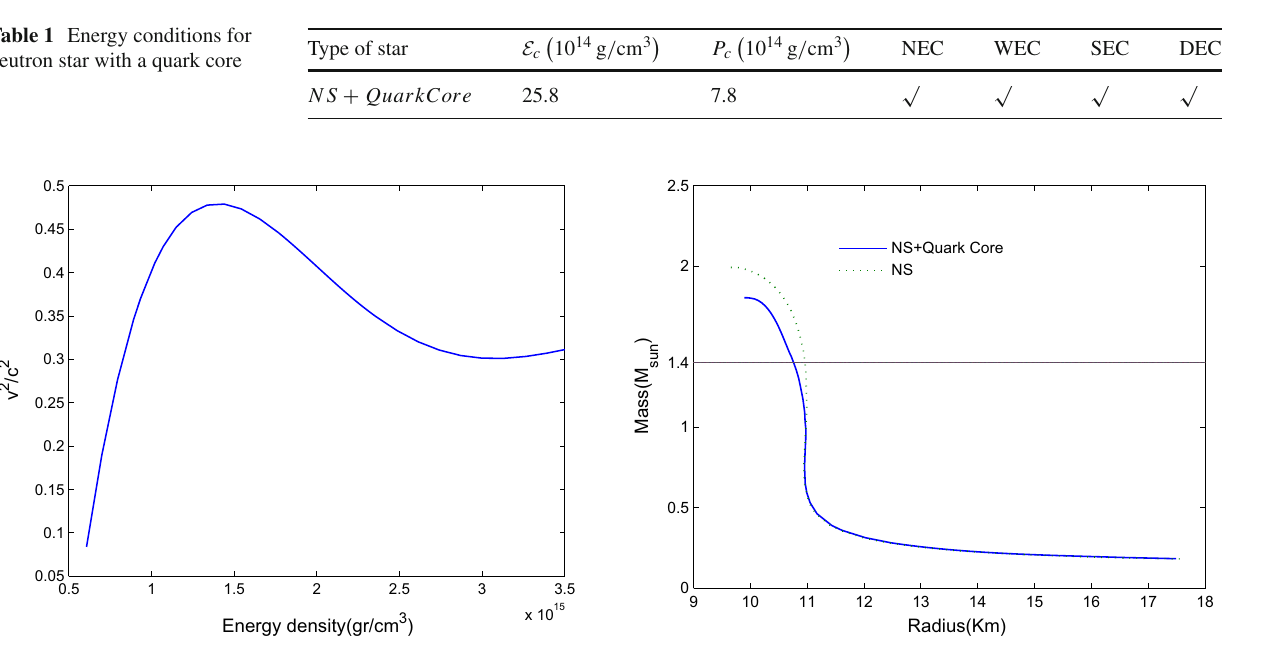
Fig. 1 Sound speed versus density Fig. 2 Mass-radius relation for the neutron stars with and without the quark matter